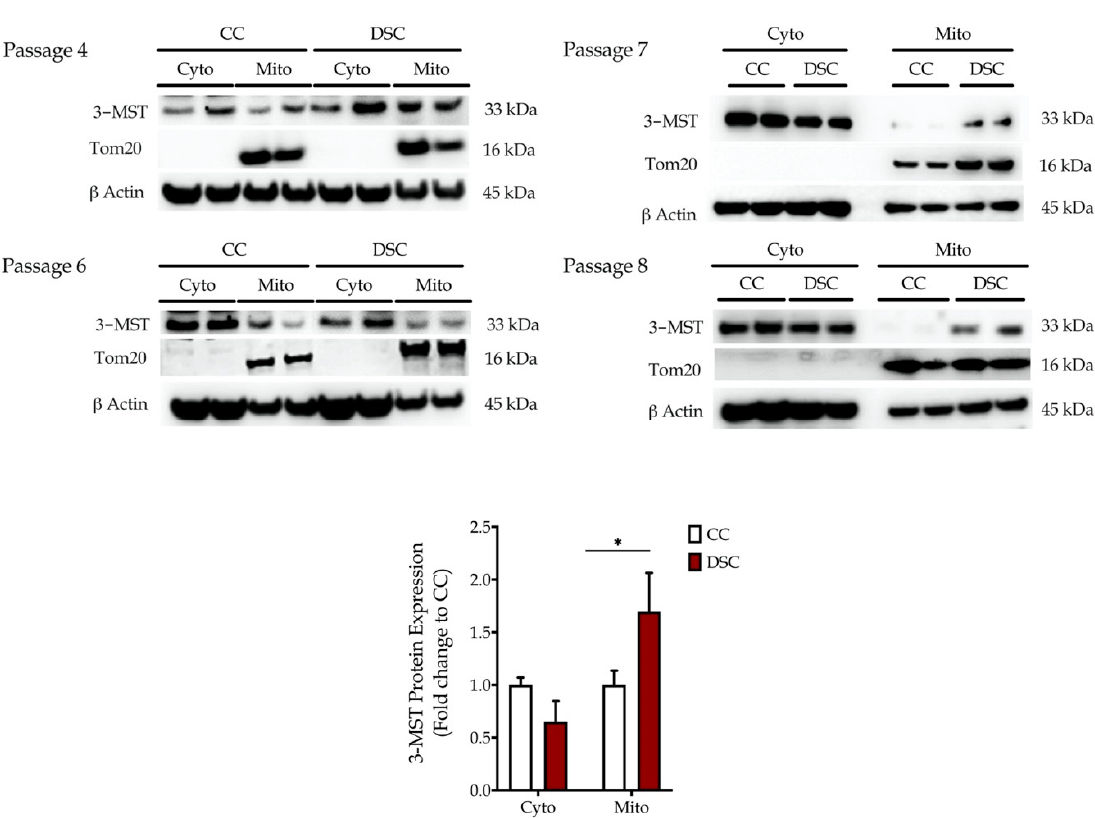
Figure 2. 3-MST accumulates in the mitochondria of Down syndrome cells (DSC) compared to healthy control cells (CC) as shown by Western blotting. Top panels: chemiluminescence images of 3-MST protein expression in cytosolic (Cyto)- and mitochondrial (Mito)-enriched fractions of the selected healthy control fibroblast (Detroit 551; CC) and the Down syndrome fibroblast (Detroit 539; DSC). Experiments using four different cell passages are shown. The Western-blot analysis utilized β -actin as a loading control. The outer mitochondrial membrane transport protein Tom20 served as a control for the purity of the mitochondrial-enriched fractions. Bottom graph: statistical analysis of the healthy control fibroblast (Detroit 551; CC) and the Down syndrome fibroblast (Detroit 539; DSC). * p < 0.05.